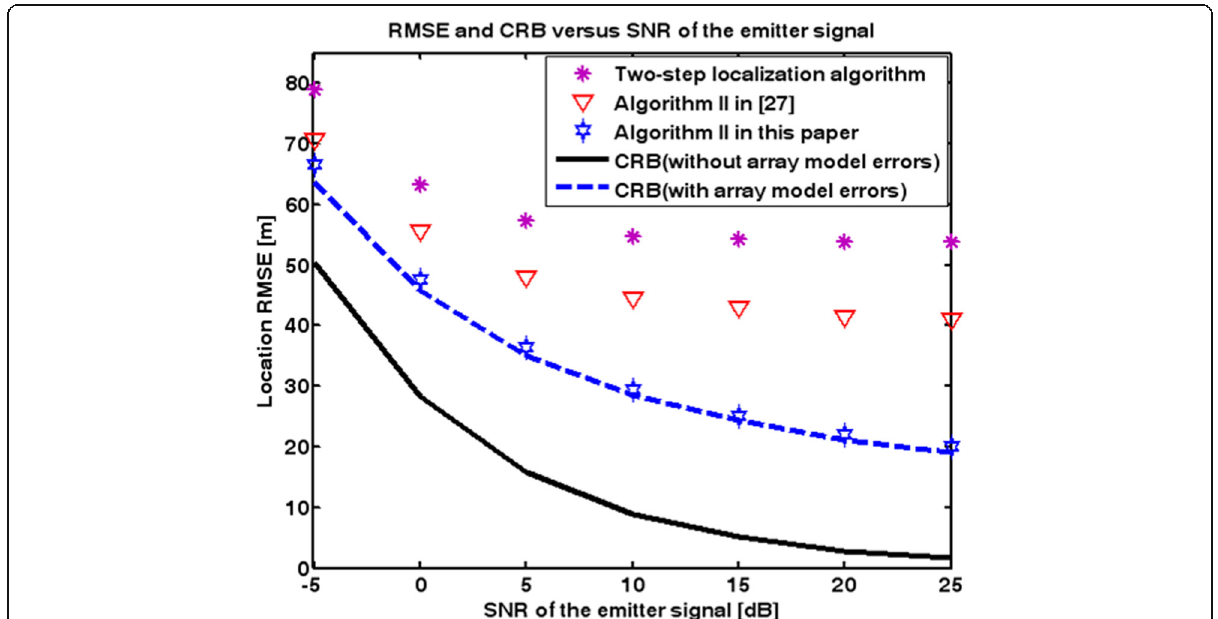
Fig. 7 RMSEs of localization methods and the corresponding CRBs as a function of SNR of the emitter signal for case of known signal